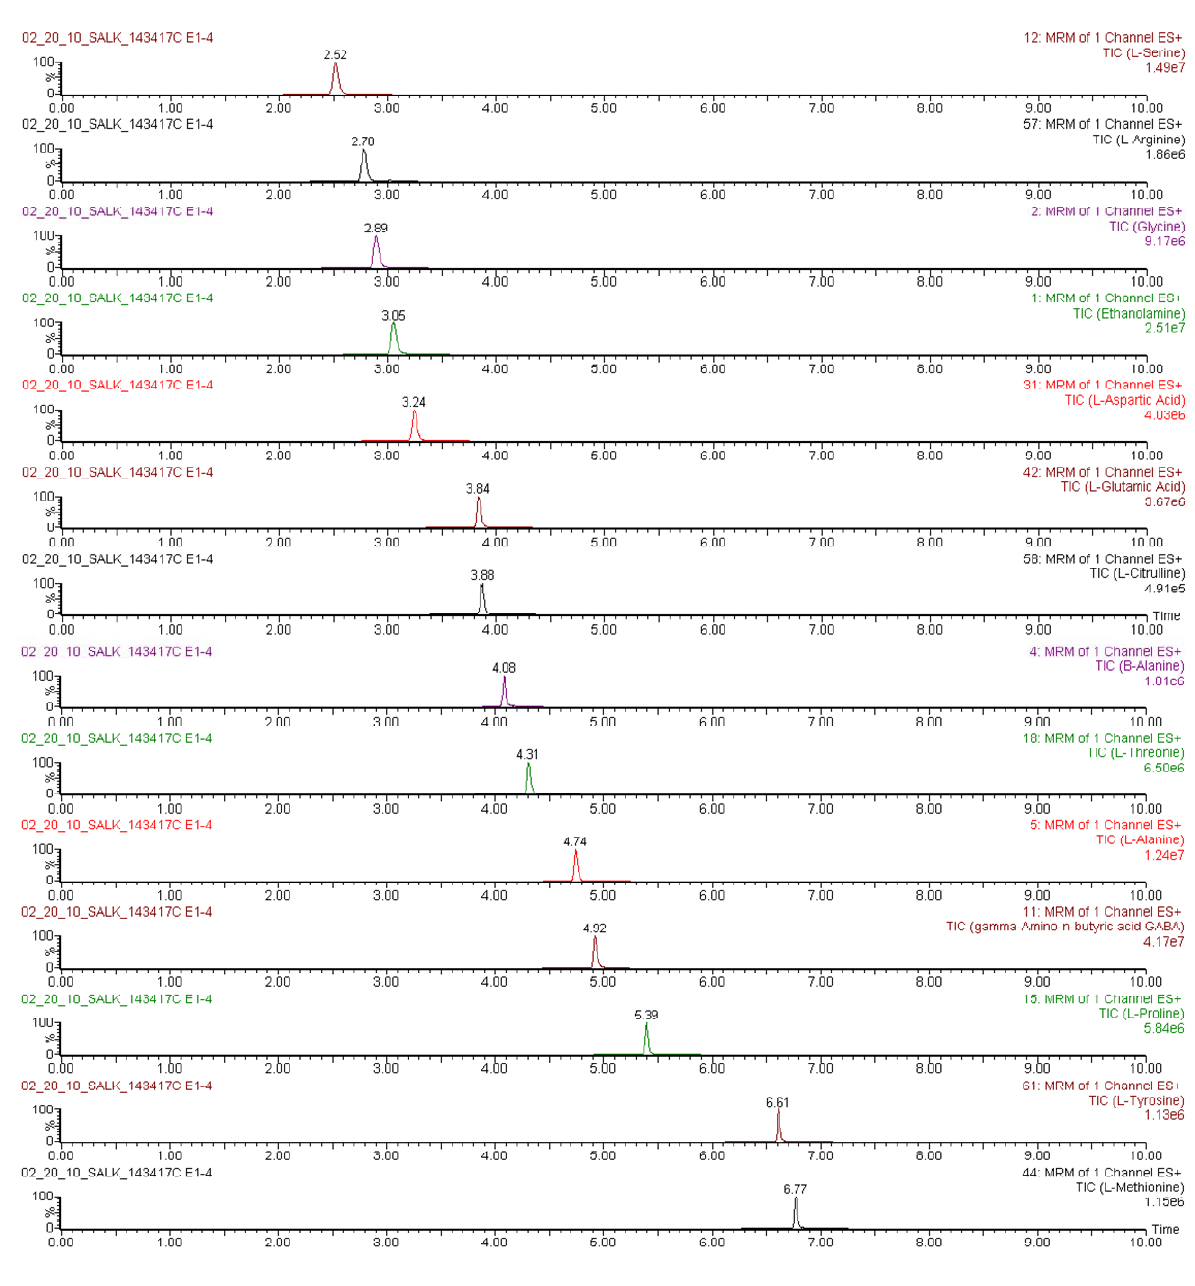
Figure S2 . Mass chromatograms of AQC-derivatized amino acids quantified in an Arabidopsis thaliana leaf extract, obtained by UPLC-ESI-MS/MS in multiple reaction monitoring